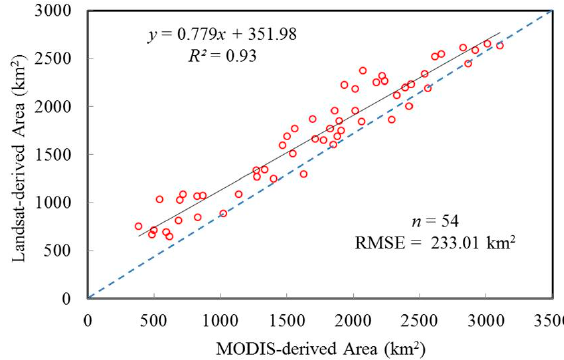
Figure 3. The accuracy assessment results of Moderate Resolution Imaging Spectroradiometer (MODIS)-derived grassland area. The vertical axis shows the Landsat-derived grassland area and the horizontal axis shows the MODIS-derived grassland area. The perfect agreement line (1:1) and linear regression are also plotted.